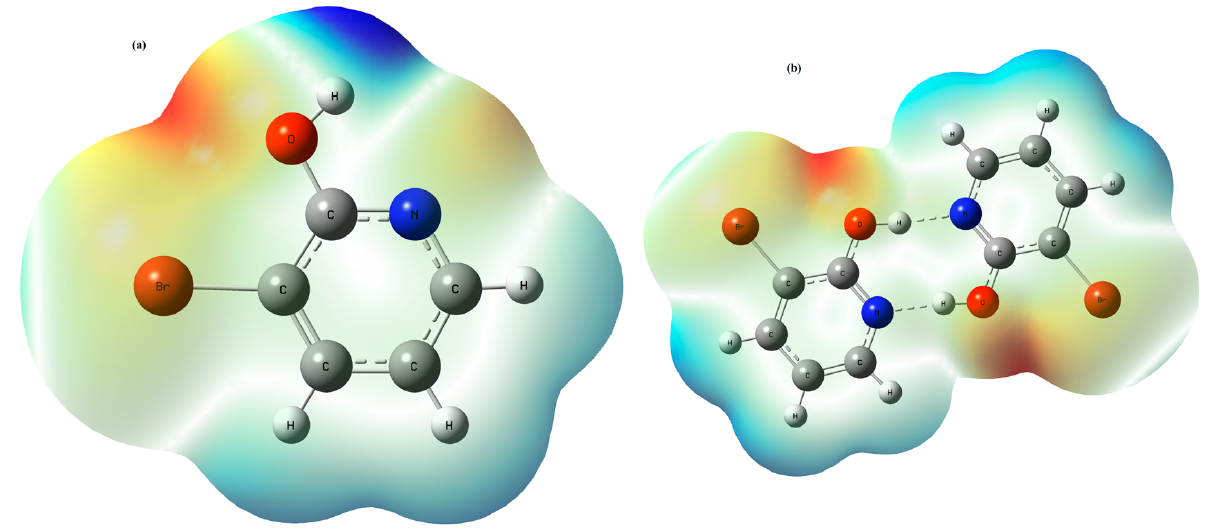
Figure 3. 3D molecular electrostatic potential contour map of 3-Br-2-HyP monomer ( a ) and dimer ( b ) calculated at B3LYP/6-311++G(d,p) level.